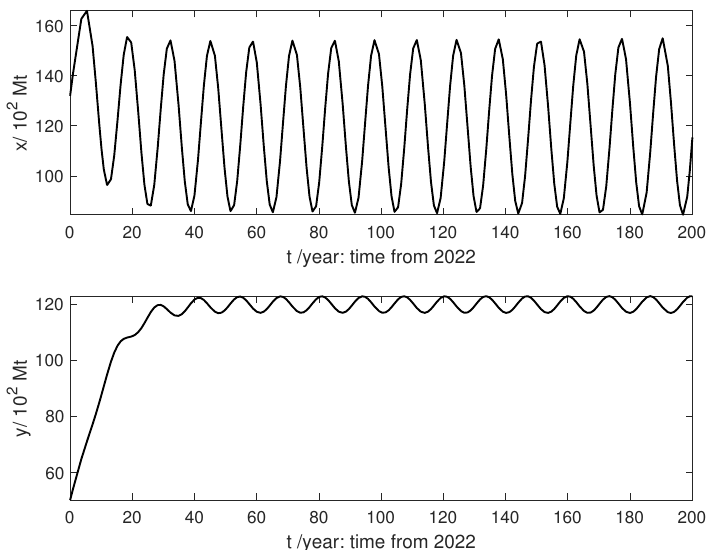
Figure 7. When τ = 3.61, the system (3) has a stable periodic solution near the equilibrium E 3